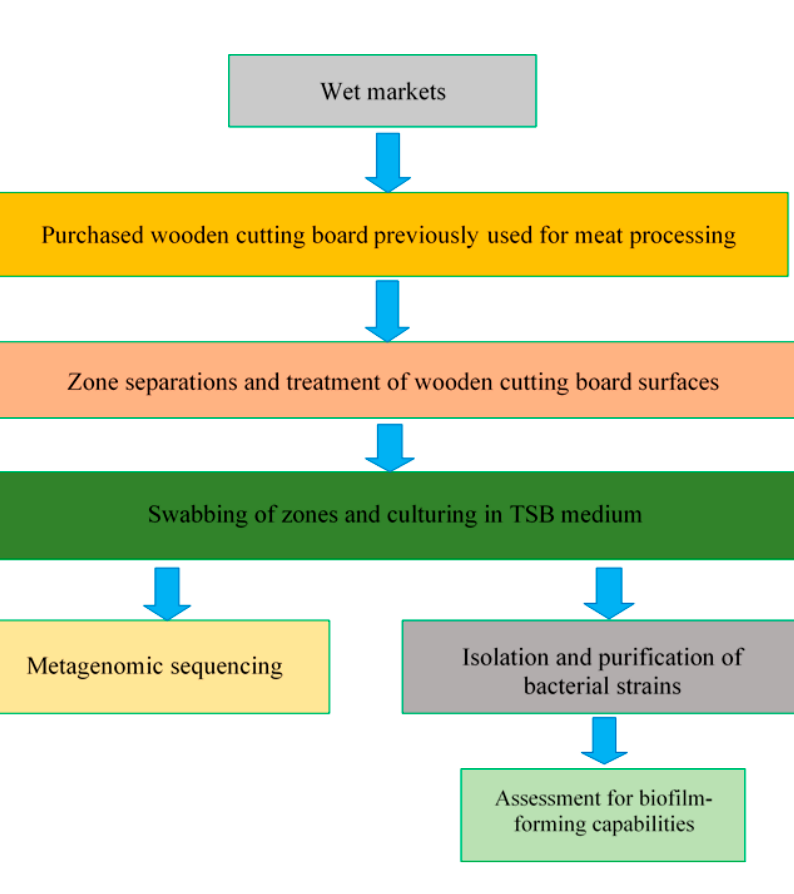
Figure 2. Schematic representation of the experimental plan.